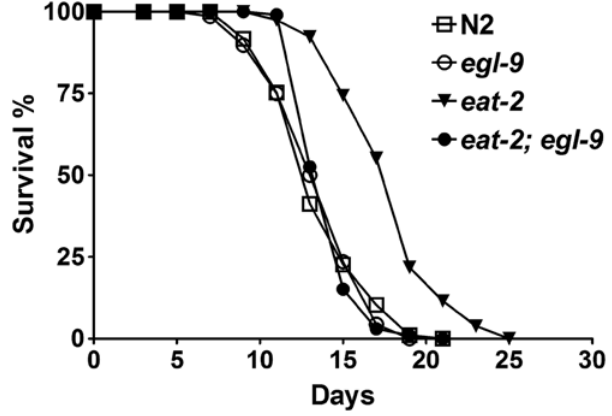
Figure 4. egl-9 suppresses lifespan extension by the eat-2 mutation. The lifespan experiments were performed twice with consistent results. Quantitative data and statistical analyses for the experiments shown here and the repeated experiments are included in Table 2 and Table S2, respectively. doi:10.1371/journal.pgen.1000486.g004 PLoS Genetics |